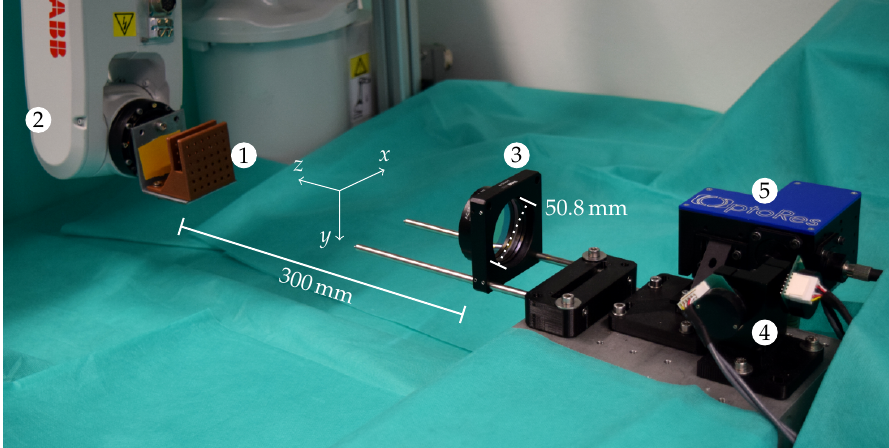
Figure 6. A sample can be mounted to the holder (1) which is attached to the robot arm (2) in front of the scan lens (3), the second pair of galvos (4), and the scan head